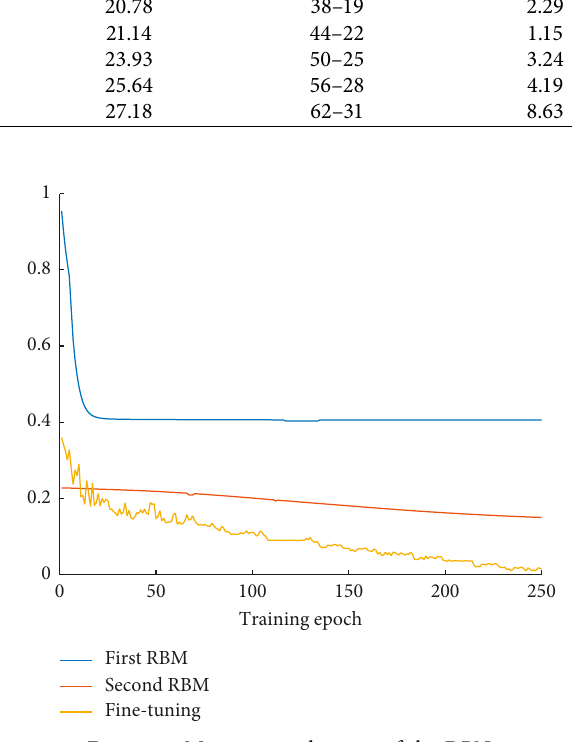
Figure 5: Mean squared errors of the